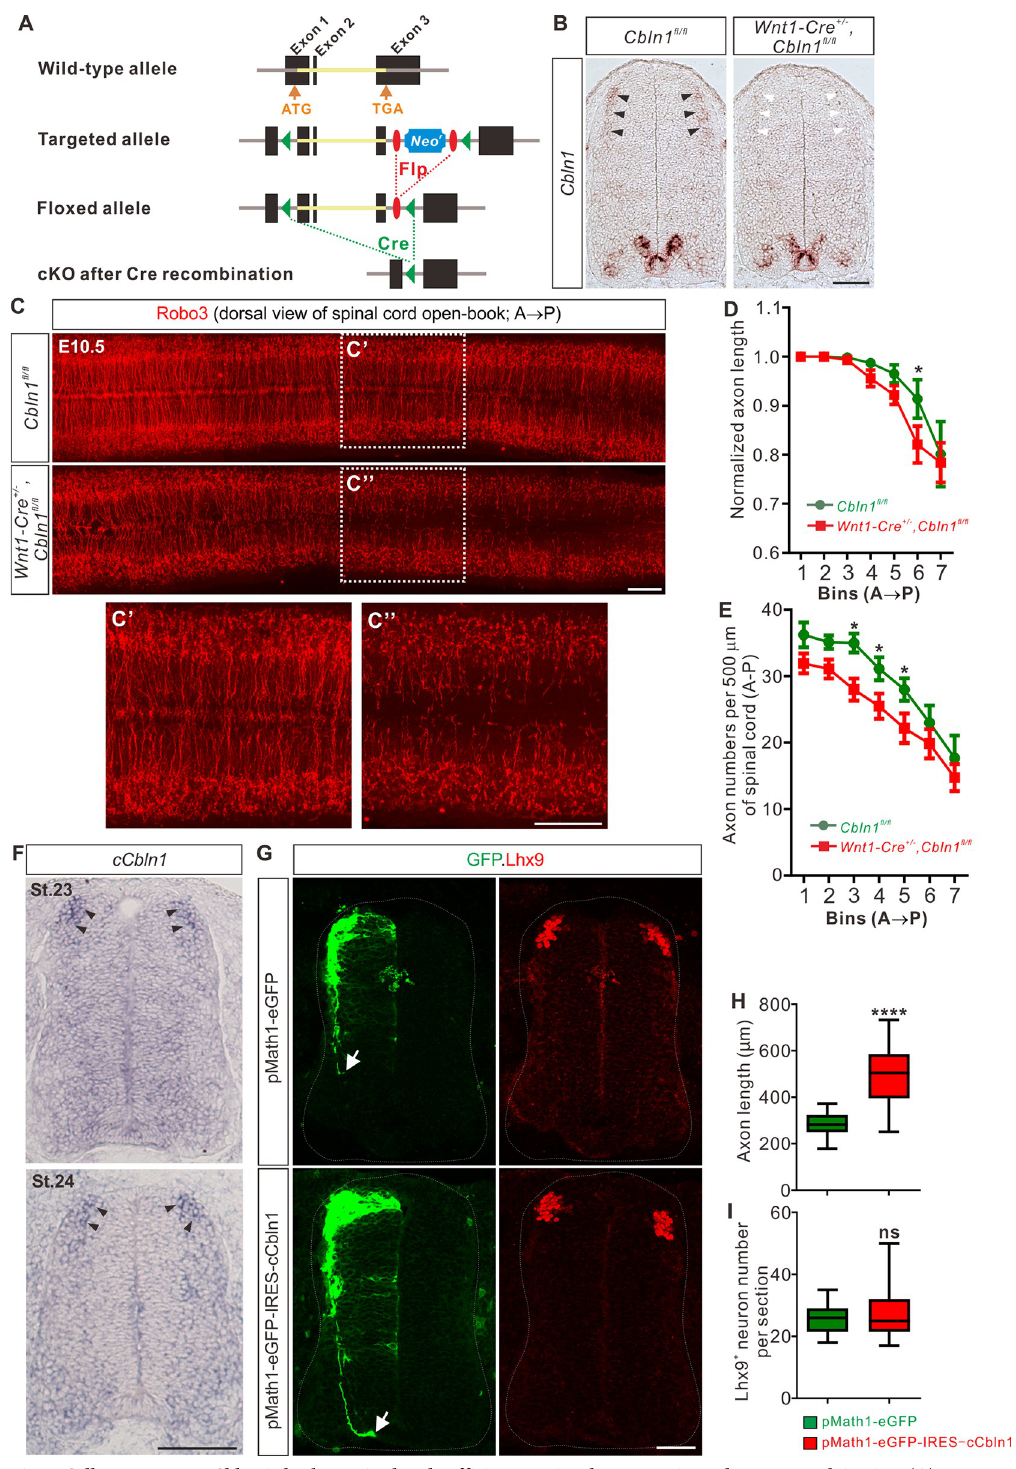
Fig 2. Cell-autonomous Cbln1 is both required and sufficient to stimulate commissural axon growth in vivo. ( A ) Schematic drawings showing the generation of Cbln1 cKO. The coding sequence of Cbln1 is deleted after Cre-mediated recombination. ( B ) Specific depletion of Cbln1 in the dorsal spinal cord of Wnt1-Cre +/- , Cbln1 fl/fl cKO mouse embryos. In situ hybridization of E11.5 spinal cord sections using RNA probes against Cbln1 confirmed specific ablation of Cbln1 from the DCNs. Black arrowheads indicate Cbln1 expression in control DCNs and white arrowheads highlight the missing